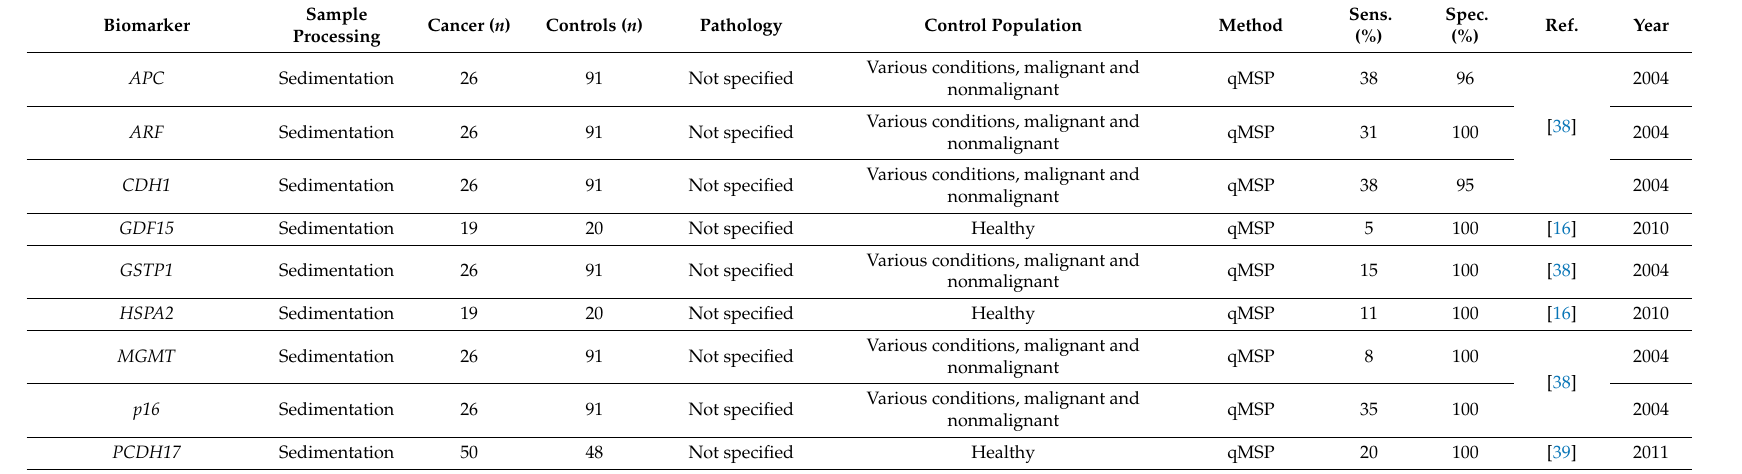
Table 4. DNA-methylation biomarkers and biomarker panels for detection of renal